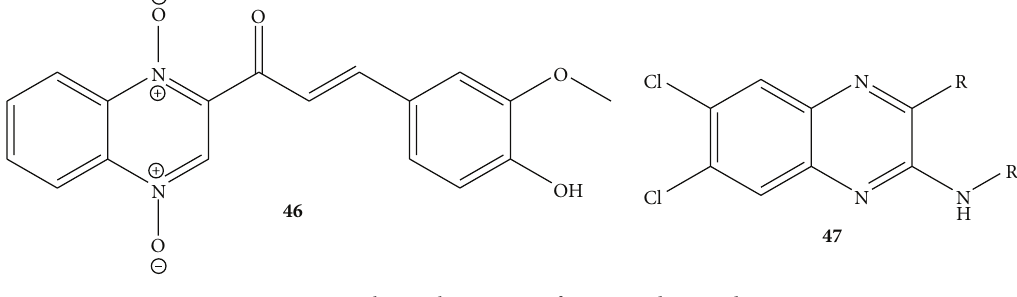
Figure 14: Chemical structures of compounds 46 and 47 .